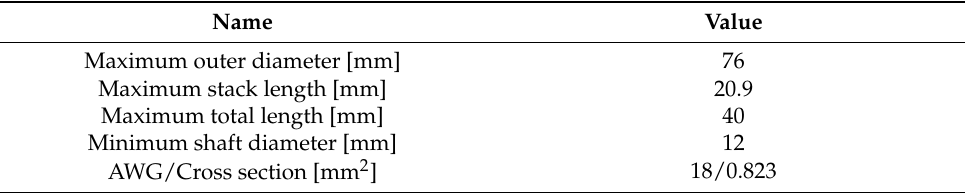
Table 4. Main geometrical